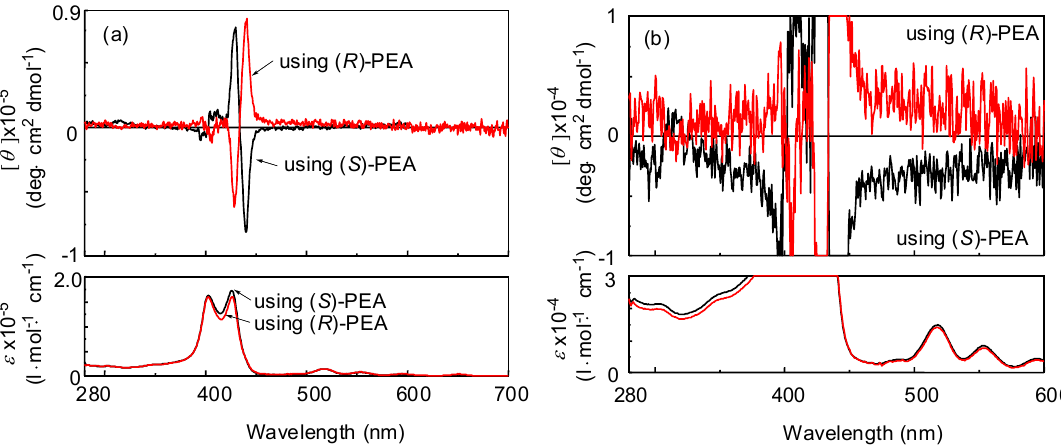
Figure 1. ( a ) CD and UV-vis spectra of poly( 1 ) in THF at 20 ◦ C; ( b ) enlargement of the CD and UV-vis spectra in (a) for Y-axis.